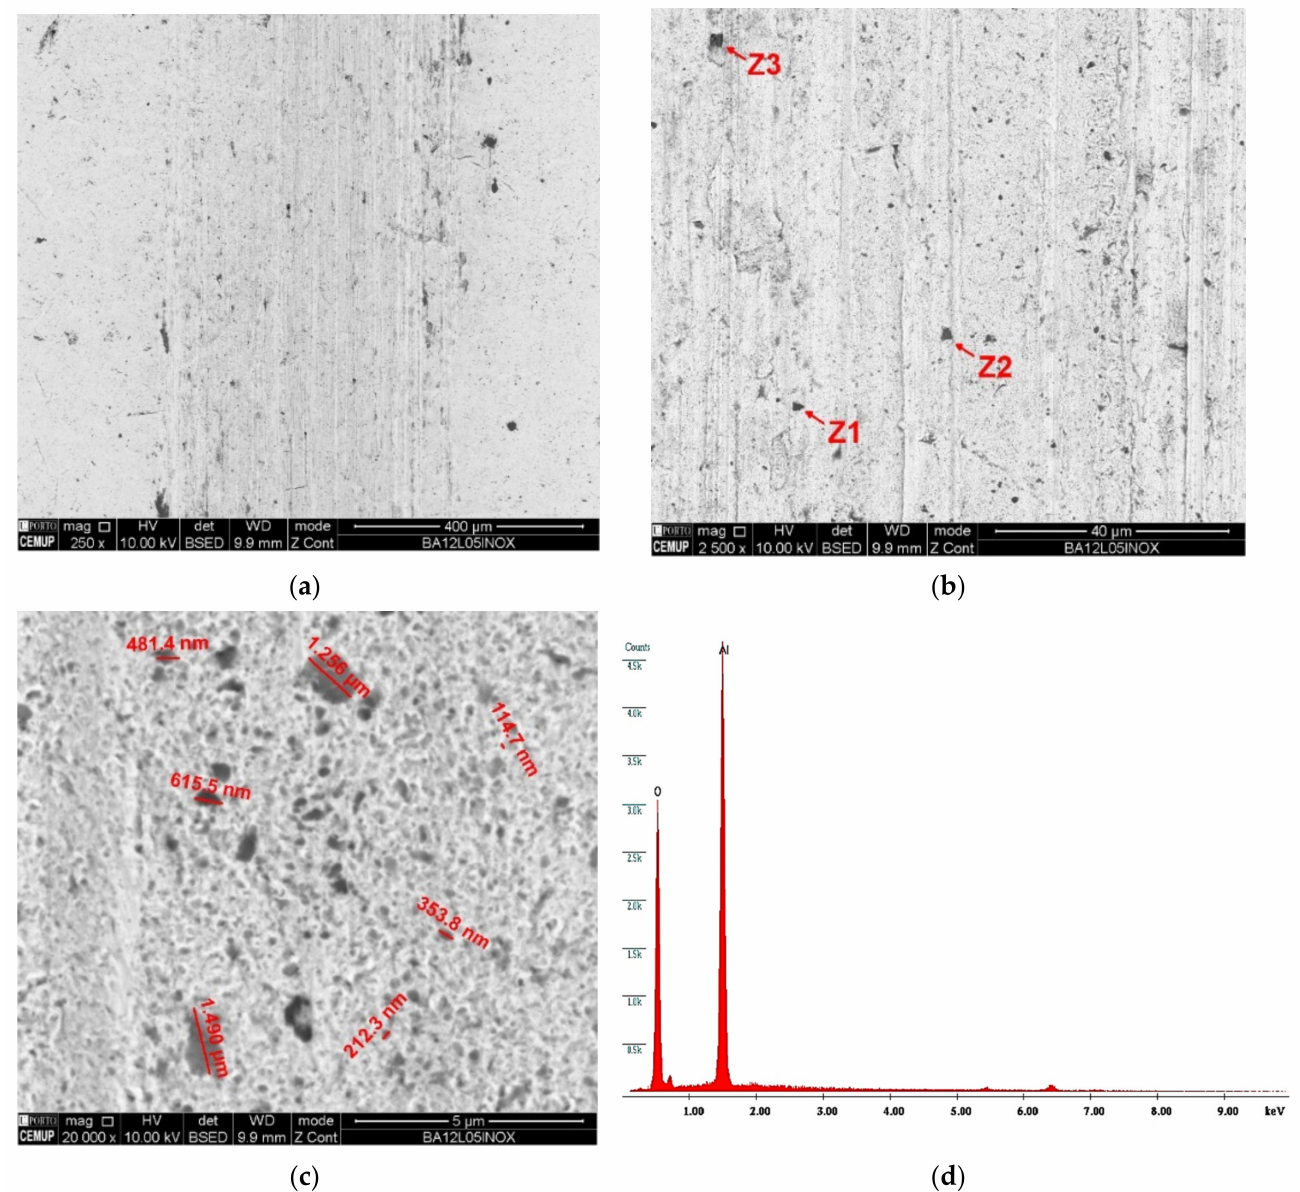
Figure 18. SEM track analysis for abrasive alumina powder (1 µ m) with 0.5 N load for SS AISI 304 ball: ( a ) track on the ball, ( b ) embedded alumina particle, ( c ) alumina particle dimension, ( d ) EDS spectrum in the Z2 zone indicating alumina